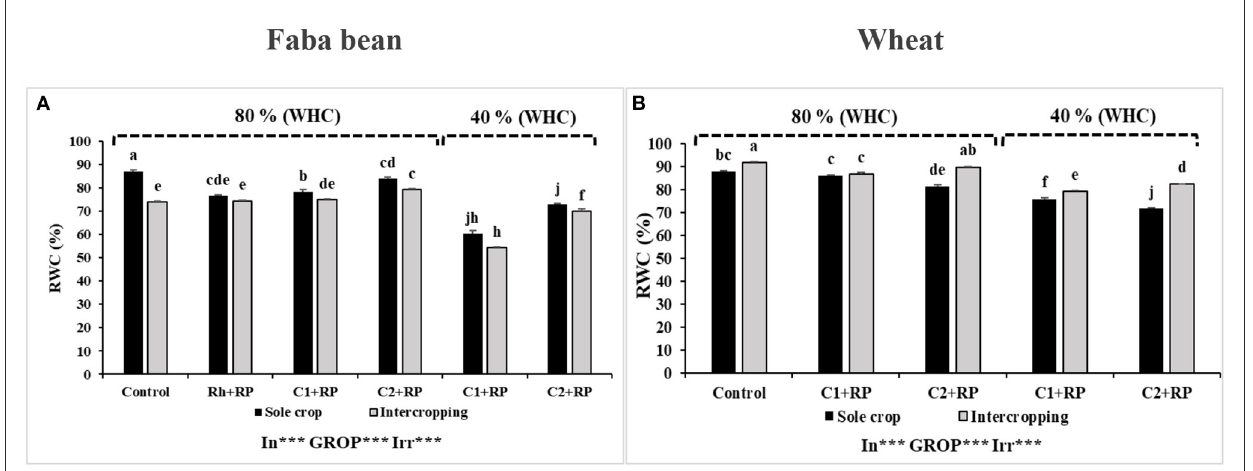
FIGURE3 Relative water content in faba bean (A) and wheat (B) grown as a sole crop or intercropped under water sufficiency and P limitation (80% WHC, RP) vs. combined water deficit and P limitation (40% WHC, RP) and inoculated with two rhizobacterial consortia (C1 and C2) containing rhizobia and two PGPRs. The positive controls were supplemented with 125 µ mol/l of KH 2 PO 4 and 46 mg/l of KNO 3 (control). The negative controls received RP and were inoculated with the rhizobia only (Rh + RP). Each value represents the mean ± standard error (SE) of three replicates (In, inoculation; GROP, type of cropping; Irr, irrigation). Values with different letters are significantly different at 0.05 level of probability by Student-Newman-Keuls. * Represent the significance level of treatments.